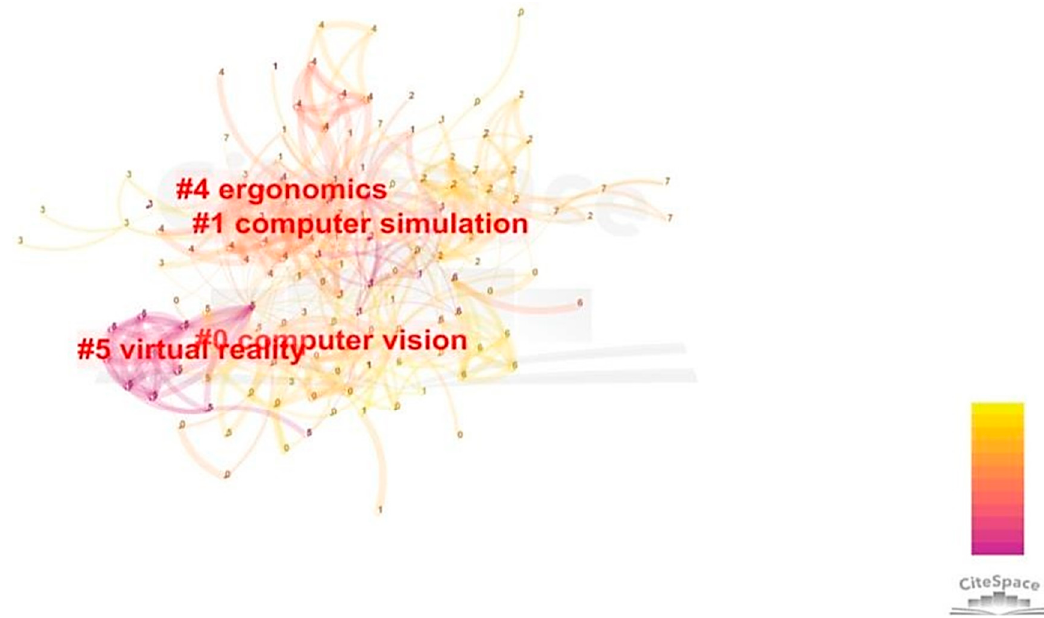
Figure 7. Cluster analysis. Table 2. The top three most frequently occurring keywords in each cluster except the cluster label.